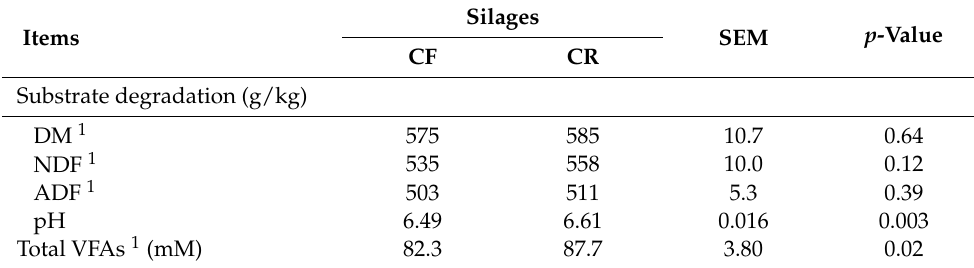
Table 4. The fermentation end-products for silage of corn stover after fresh-corn harvested (CF) and corn stover after ripe-corn harvested (CR) after 48 h in vitro ruminal